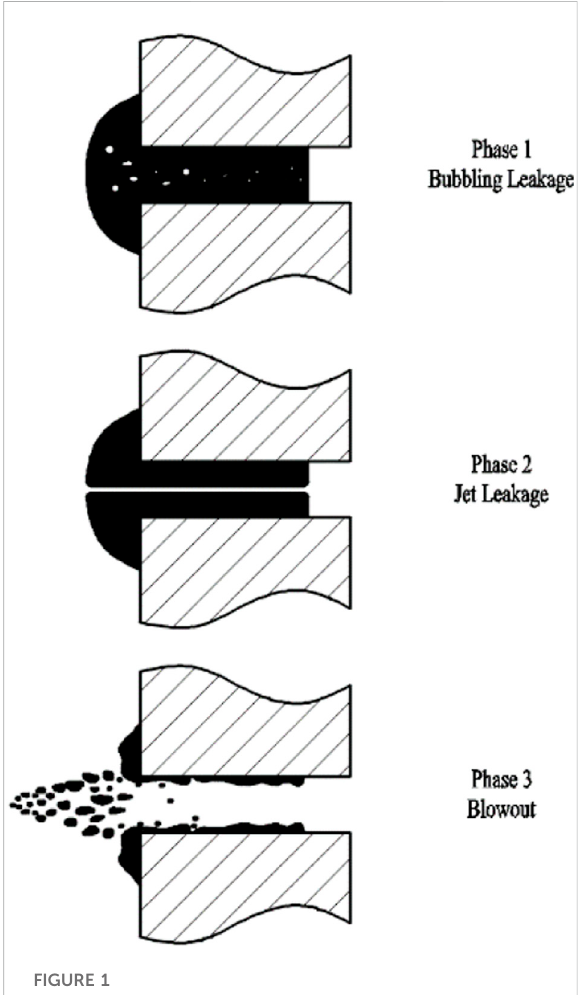
FIGURE 1 Phases in magnetic fl uid sealing